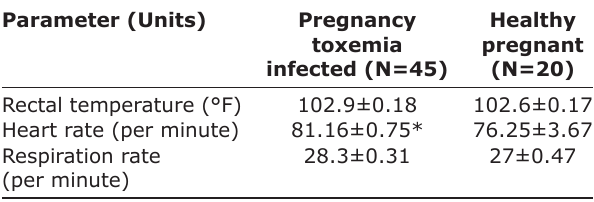
Table-1: Vital signs observed in pregnancy toxemic and healthy goats.